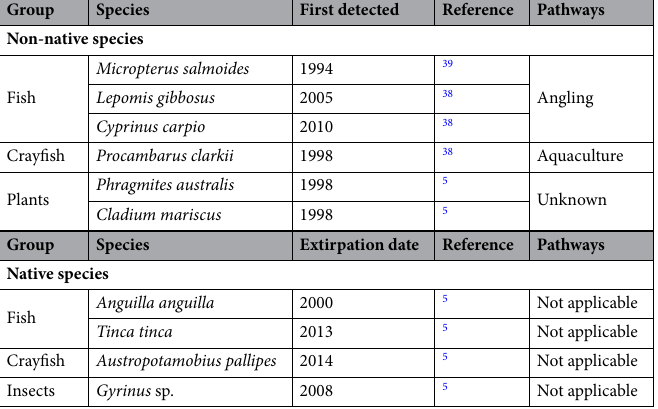
Table 1. Non-native species present in Arreo Lake, showing the year of its first detection and the most likely